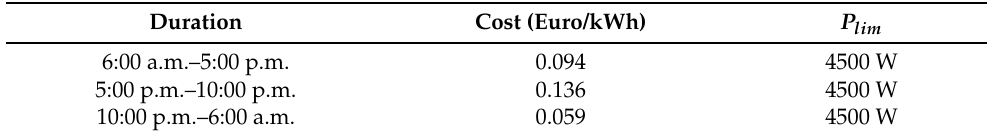
Table 3. Pricing tariff